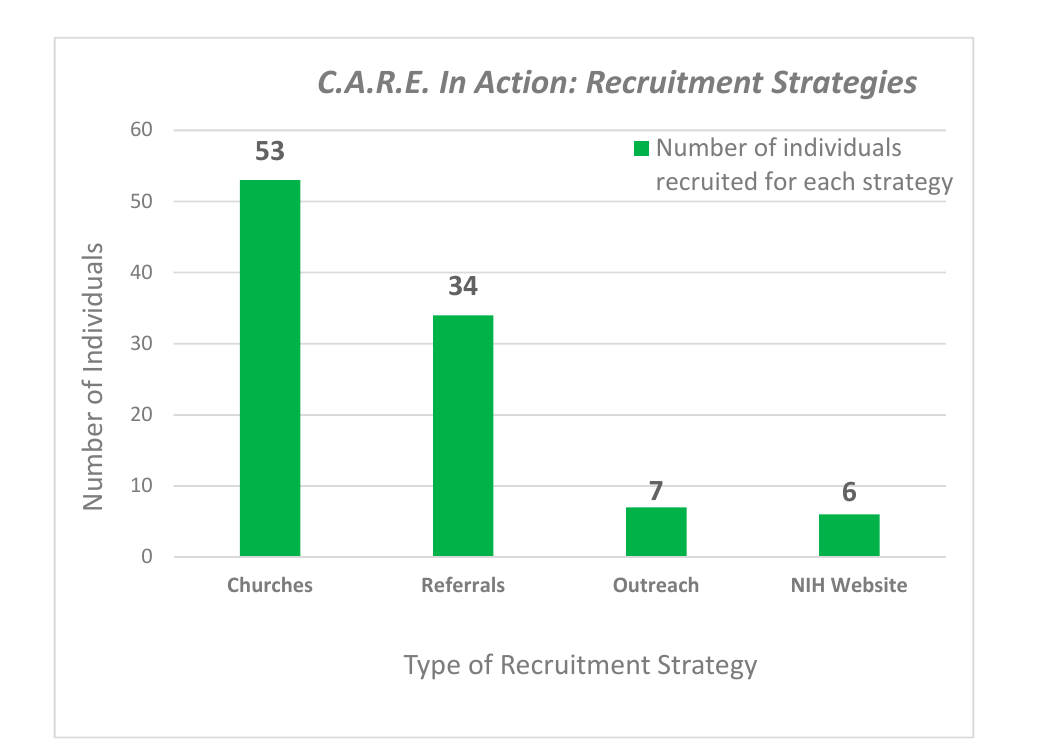
Figure 2. C.A.R.E in Action. Four types of recruitment strategies were used during this pilot.